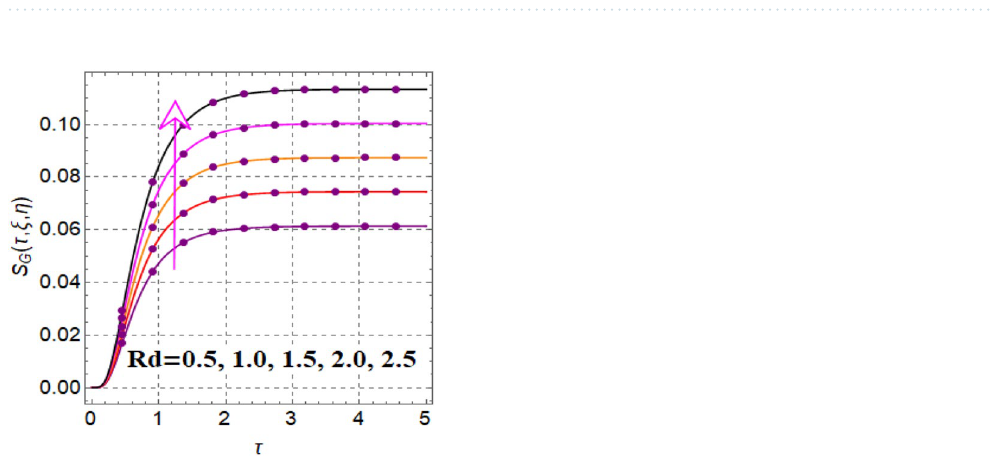
Figure 14. S G (τ , ξ , η) via Br .